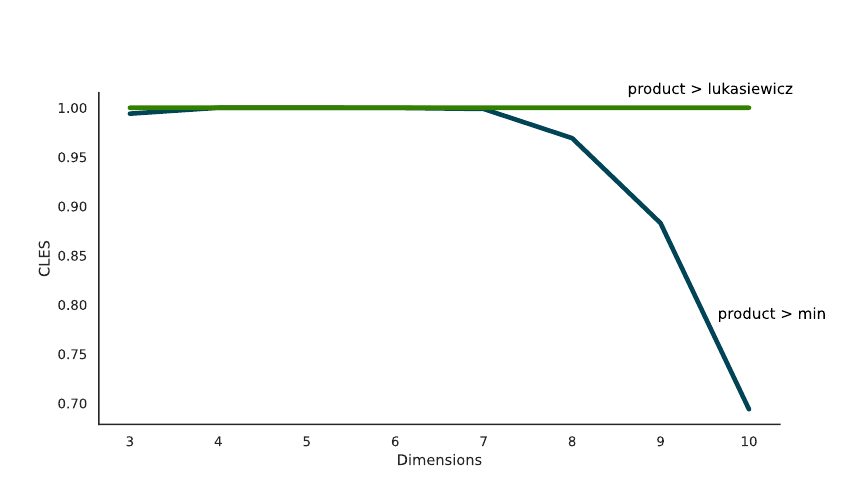
Figure 2: CLES value obtained through Wilcoxon signed-rank test for each dimension.